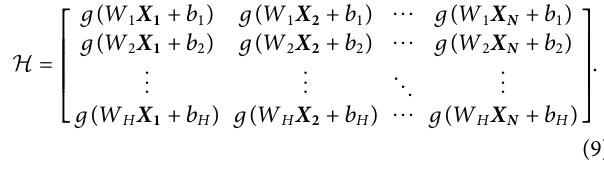
Figure 1C . Given a training set [ X , Y ] the main steps of ESn are as follows (Qiao et al., 2016; Wang et al., 2019). Randomly generate a reservoir weight matrix W with the prede fi ned sparsity and size. In order for the reservoir to have echo-state property, the singular values of reservoir weight matrix of the reservoir must be scaled to within 1, so scaled W as here 0 < α < 1 and Ψ is the spectral radius of W . Next, randomly generate the weight matrix between input layer and reservoir, denoted as W in . And initialize the reservoir states £ (0) . Calculate the state of reservoir by using dynamic equation, £ (n+1) = F ( £ (n) + W in X n + 1 ) , here £ (n) and £ (n+1) are reservoir states, F (·) is activation function, X n+1 represent ( n + 1)-th sample